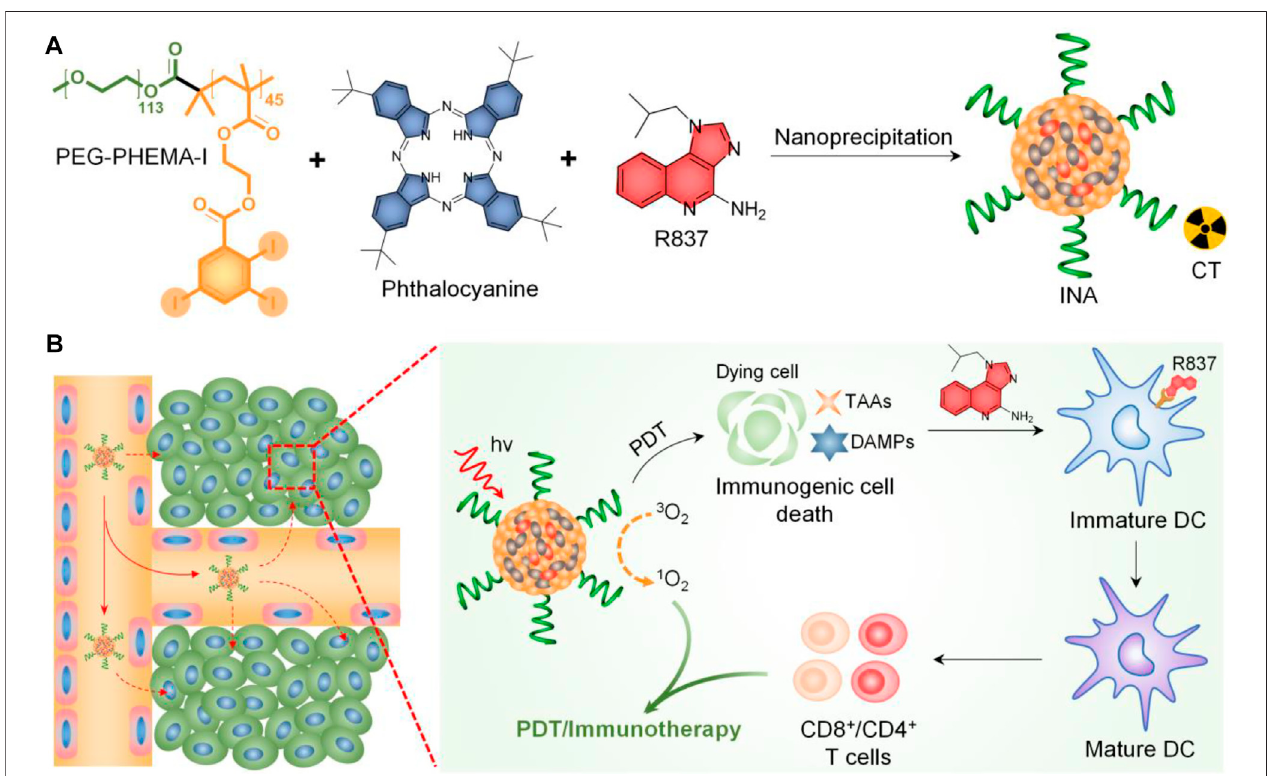
FIGURE1|(A) SchematicillustrationofINApreparation. (B) SchematicillustrationofthemechanismofINAforNIRlightsynergisticphotodynamicimmunotherapy.